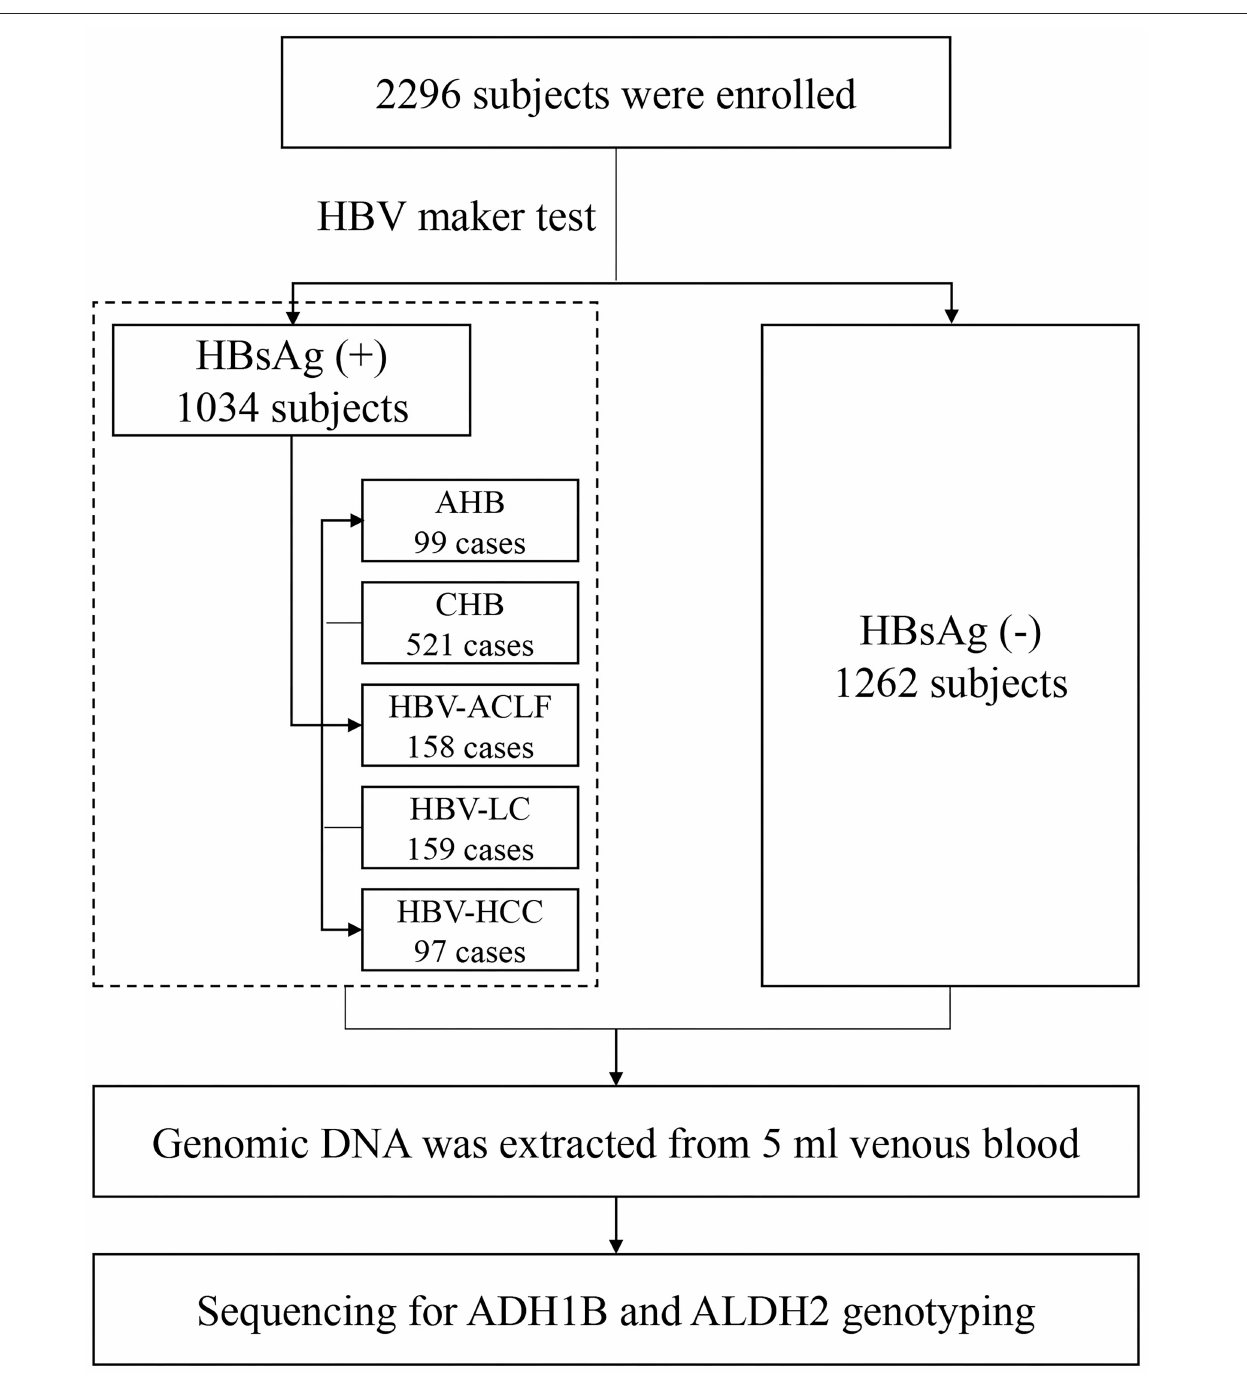
FIGURE 1 | Flow chart of subjects included. HC, health control; AHB, acute hepatitis B; CHB, chronic hepatitis B without ACLF, LC, and HCC; LC, HBV-related liver cirrhosis; HCC, HBV-related hepatocellular carcinoma.